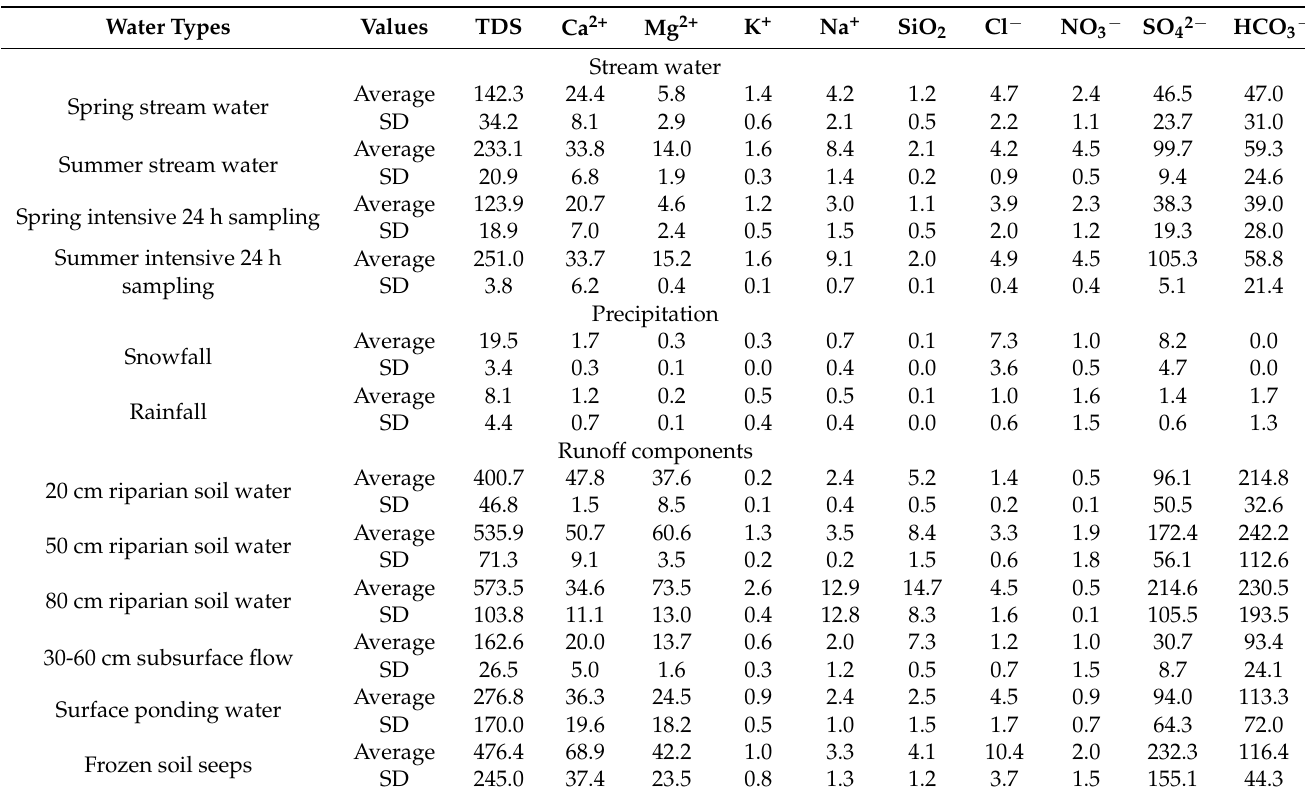
Table 1. Major ions, Si, and total dissolved solids (TDS) of the different water types (unit of major ions, Si, and TDS: